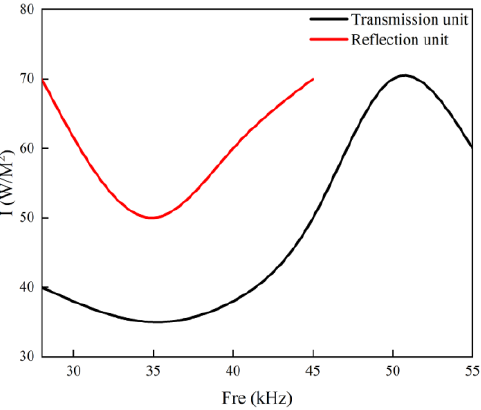
Figure 18. The influence of frequency on the sound intensity at the focal point of transmitted and reflected waves.